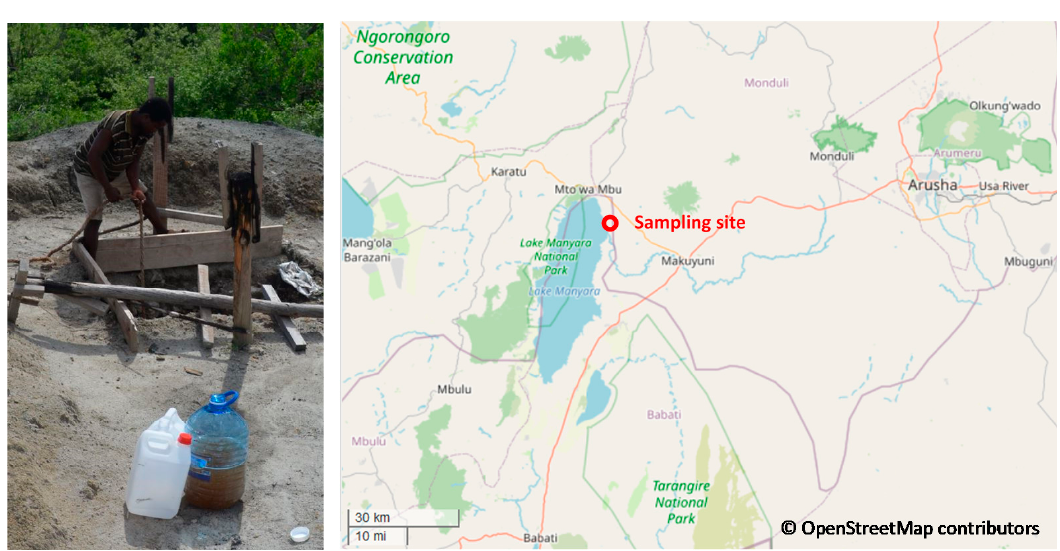
Figure 3. Left: photo of the open well for sampling ( © Andrea Iris Schäfer); right: geographical location of groundwater sampling site (Burudika Lodge, Lake Manyara, Tanzania, map © OpenStreetMap contributors under the Open Database License). Table 4. Water quality of the groundwater samples in the Esilalei area (samples 1–4 were analyzed at Engler-Bunte Institute (EBI-KIT), and sample 5 was analyzed at the Beijing University of Chemical Technology (BUCT). Sample 5 was used as the feed solution in this study. Water quality variation occurs with location, season (in particular, rainfall) and probably extraction method/volume. The data in grew shadow indicate the quality parameters are most important.